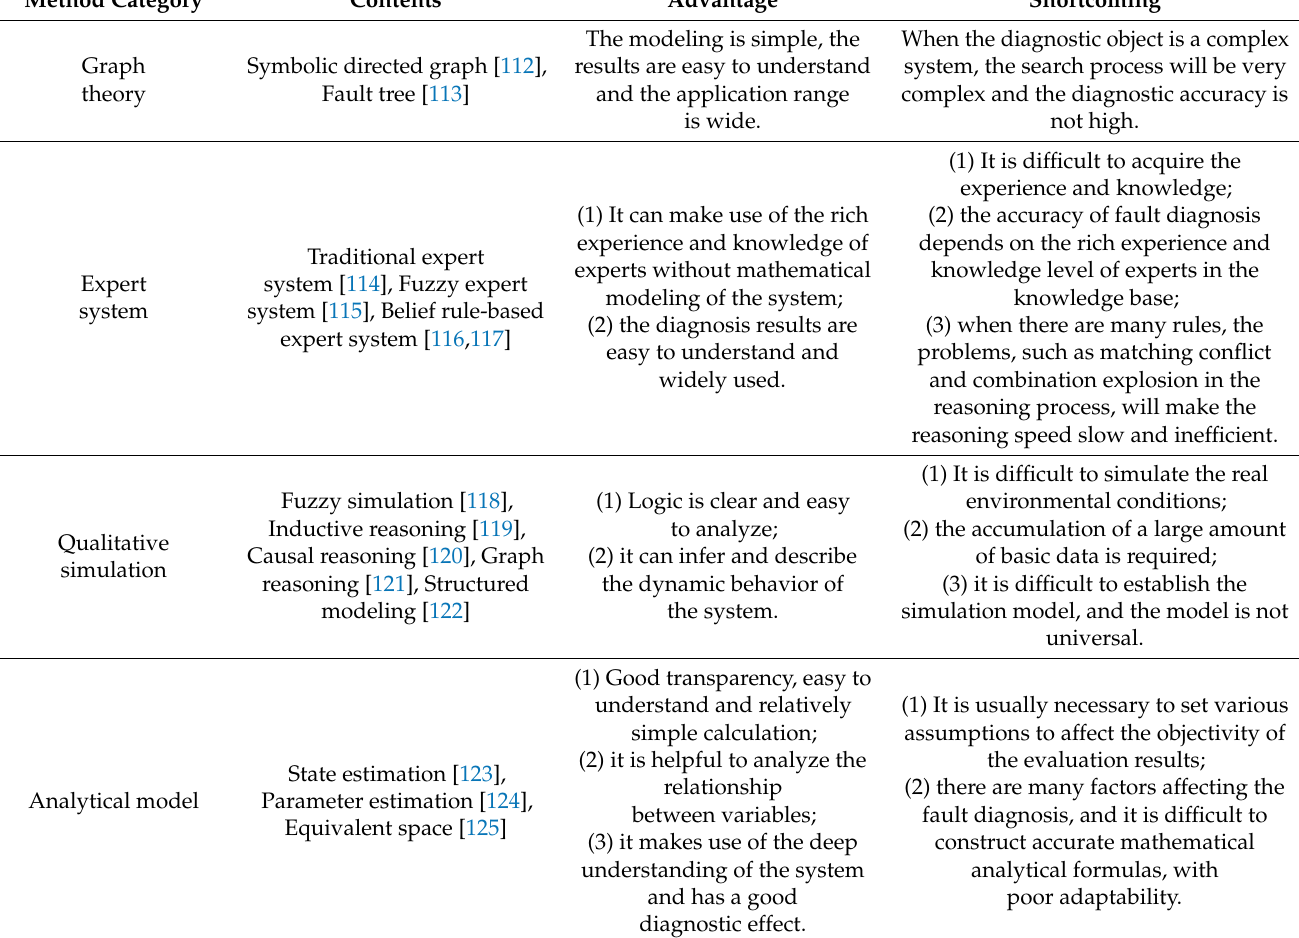
Table 2. Summary and analysis of existing fault diagnosis